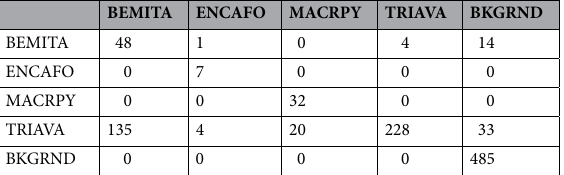
BEMITA ENCAFO MACRPY TRIAVA BKGRND